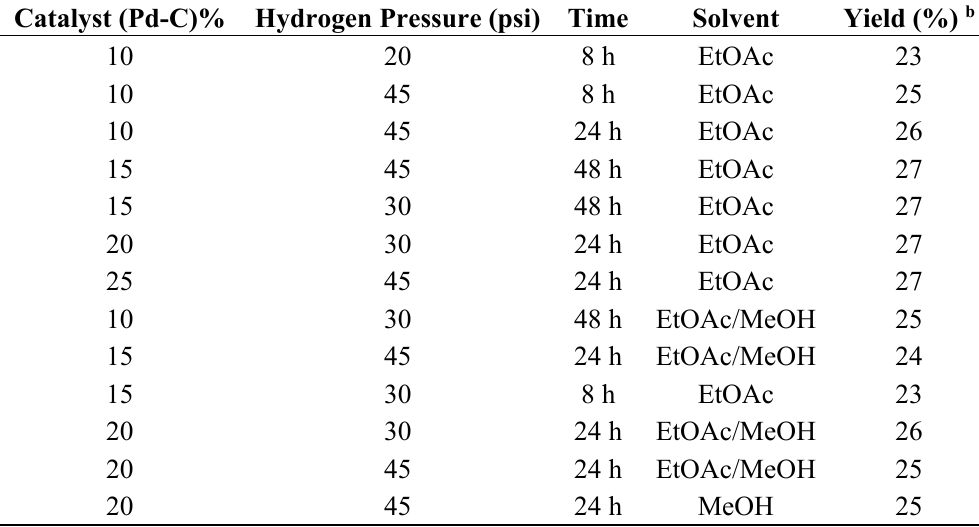
Table 1. Preparation of compound 8 by catalytic hydrogenation of aldehyde 7 . Catalyst